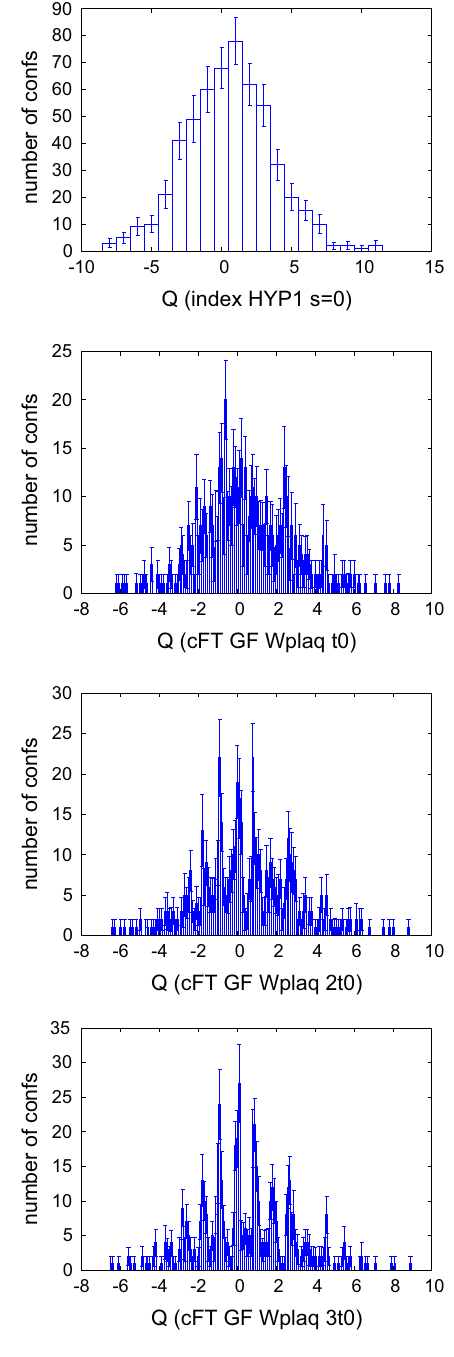
Fig. 8 Histograms of the topological charge for ensemble b40.16. The employed definitions are: index of the overlap operator evaluated on configurations with 1 step of HYP smearing applied (top left) and the Wilsonflowatflowtimes t 0 (topright),2 t 0 (bottomleft)and3 t 0 (bottom